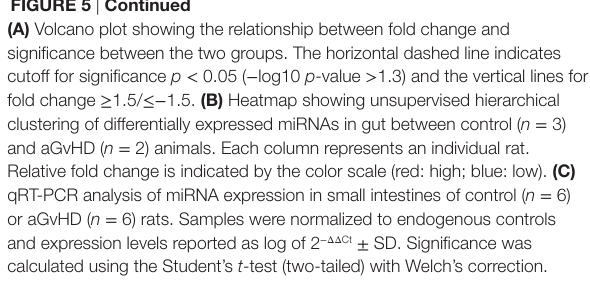
TaBle 2 | Differentially expressed mirna in Tcr αβ + T cells from the iel compartment. gene Fold change p -value